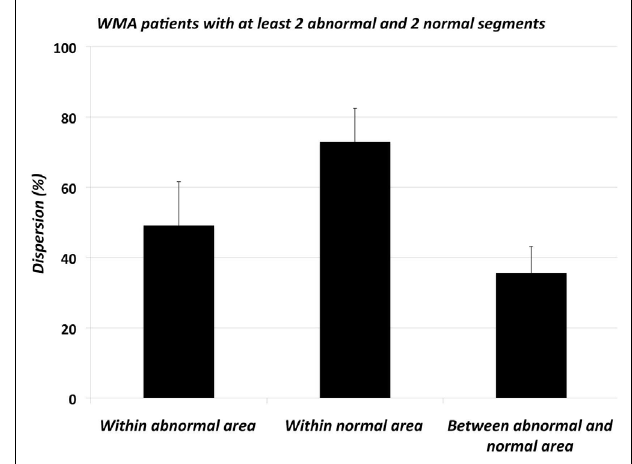
FIGURE 6 | Regional dispersion of activation-recovery intervals (ARIs) in patients with regional wall motion abnormalities expressed as a percentage of the total dispersion in each individual heart (WMA; n = 8, four patients withWMA did not have at least two normally contracting area as well as two abnormally contracting segments and were excluded from this analysis). Dispersion was assessed in the segments within the normal area, within the abnormal area and between the abnormal and normal areas. Regional dispersion was largest within the normally contracting area. Interestingly, the regional dispersion within the normal areas of the hearts withWMA and the hearts with normal wall motion differed significantly ( p < 0.05, not shown).